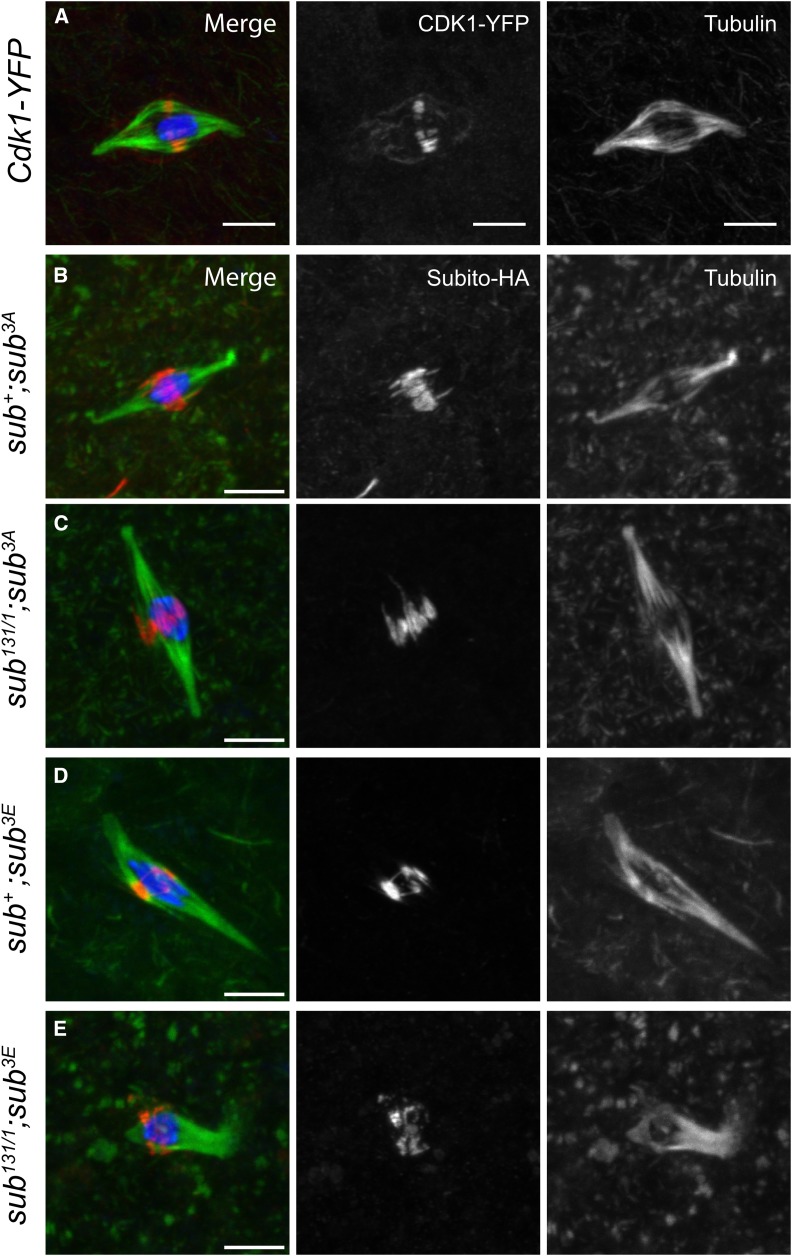
Cdk1 phosphorylation may inhibit Subito activity at meiotic metaphase I. A. Oocyte expressing CDK1-YFP (Ayeni
et al. 2014). B-D. Localization of Subito-3A or Subito-3E mutants in sub+ or sub131/1 null background (n = 7, 10 and 15 respectively). Oocytes are stained with DNA (blue), HA or GFP (red), tubulin (green). Single channels for HA or GFP and tubulin are shown in white. Scale bars are 5 µm.